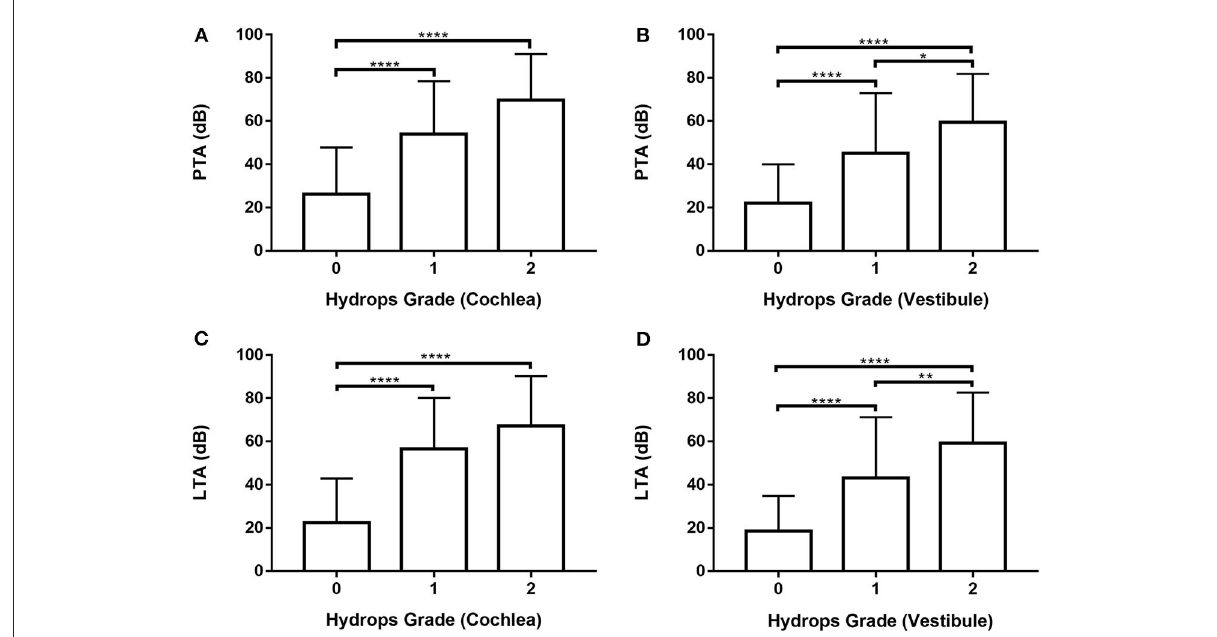
FIGURE3 Analysis of pure tone average (PTA) and low tone average (LTA) according to cochlear and vestibular hydrops grades (0–2) in 246 ears of 123 patients. (A) and (C) One-way ANOVA with Scheffé’s post-hoc multiple comparison test. (B) and (D) Welch’s ANOVA with Games-Howell’s